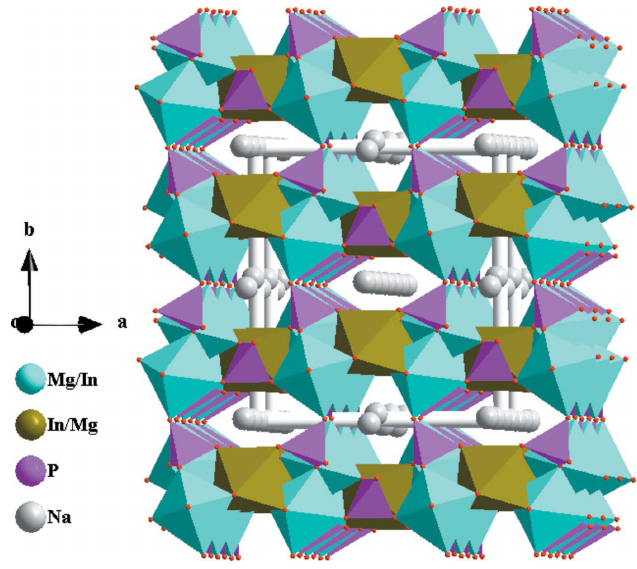
Figure 5 Polyhedral representation of the crystal structure of (I) showing Na + cations situated in the two types of channels parallel to